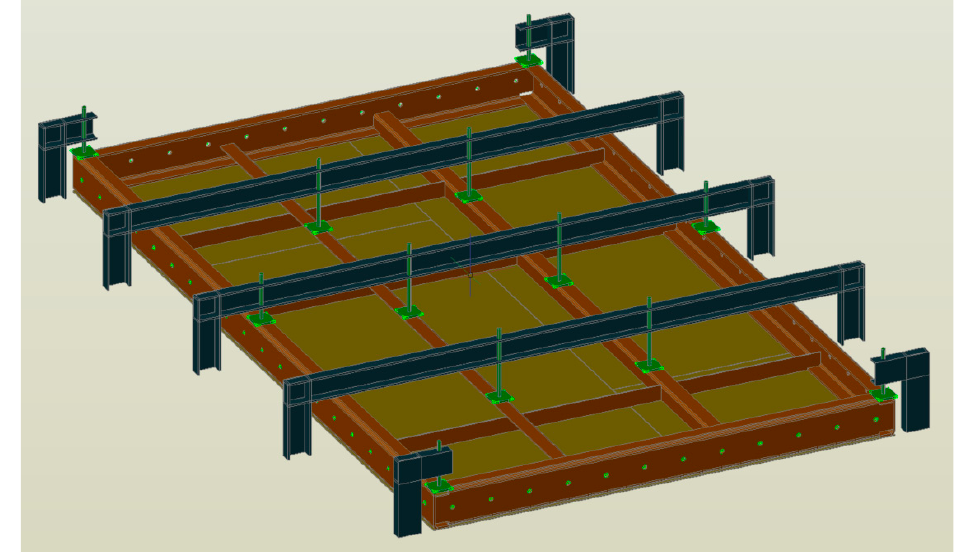
Figure 5. Diagram of the distribution of restraint points in model 1 (Figure 3a) of the welding process of the industrial furnace wall panel.